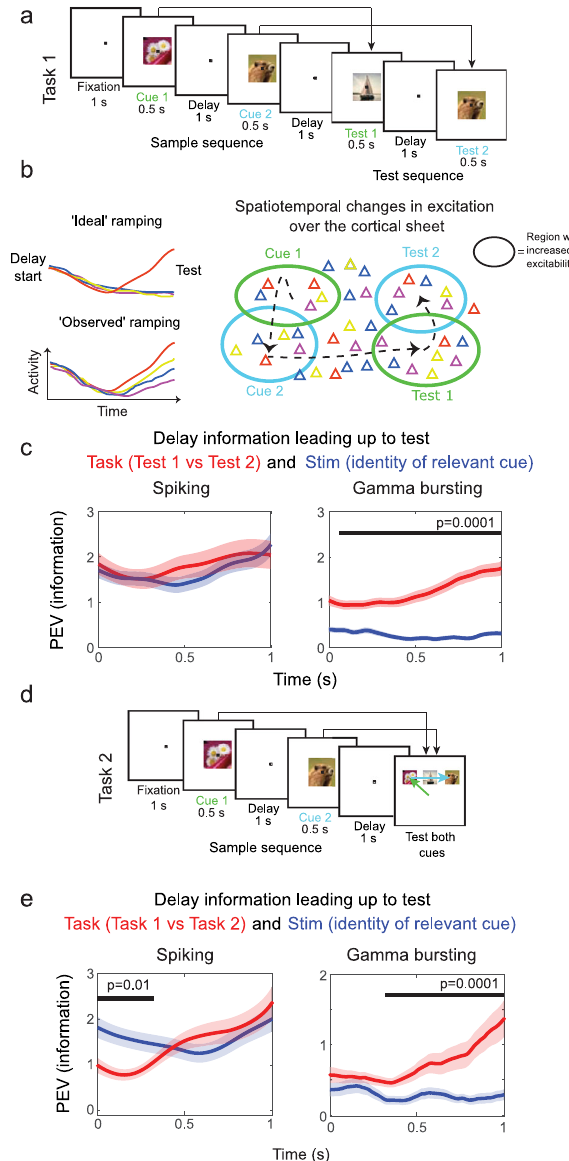
Fig. 1 | Disassociation between gamma and spiking. a In Task 1, two object cues are presented and then tested sequentially. In “ match trials ” , to which monkeys had torespond,theorderandidentityoftheobjectshavetobethesameforsampleand testsequences. b Cartoonstoillustratespatialcomputing(foractualdataseeFig.S1). Left:Item-speci fi cactivityrampsupjustbeforetheinformationaboutitemidentityis needed in the task. In the idealized case of stimulus selective neurons, their activity only ramps up for one speci fi c cued item (top). However, recorded neurons with ramping activity respond to all cued items to varying levels (bottom). Right: the modelexplainstheobservedphenomenonofpoststimulusrampingafterallstimuli to varying degrees by external time-varying excitation that travels over the cortical sheet.Neuronspreferringforinstancetheredorbluecuesarescatteredthroughout thenetwork.Somesitesexhibitrampingexcitation,re fl ectedinincreasedactivityof all neurons at that site, though to the lesser degree when the preferred object was notprovided. c RedplotsshowPEVaccountingfortestordereffectsestimatedover two groups of trial periods, delay periods preceding either Test 1 or Test 2. Blue curves re fl ect PEV wrt. cued item identity (information about identity of Sample 1 prior to Test 1 and Sample 2 leading up to Test 2 stimuli). Black bars demonstrate when blue and red plots differ, using cluster based statistics ( n =199 for gamma, n =283forsingleneurons). d Task2structure,whichisidenticaltoTask1untilTest1. Unlike in Task 1 however, at Test 1 both Sample 1 and Sample 2 items are tested in parallel by monkeys making eye-movements to the two targets. e PEV information pooledoverTask1and2inthedelayperiodleadinguptoTest1( n =199forgamma, n =283 for single neurons). Red plots show PEV estimated over periods grouped basedontask(Task1vs2),whereasbluecurvesillustratePEVinformationaboutthe cued item identity (average of information about Sample 1 and Sample 2). Shaded regionsindicatestandarderrorofthemeaninallpanels.Sourcedataareprovidedas Source Data fi le. Panels a and d were created with images from Melissa R. Warden, Earl K. Miller, The Representation of Multiple Objects in Prefrontal Neuronal Delay Activity, Cerebral Cortex, Volume 17, Issue suppl_1, September 2007, Pages i41 – i50, https://doi.org/10.1093/cercor/bhm070 with permission from Oxford University